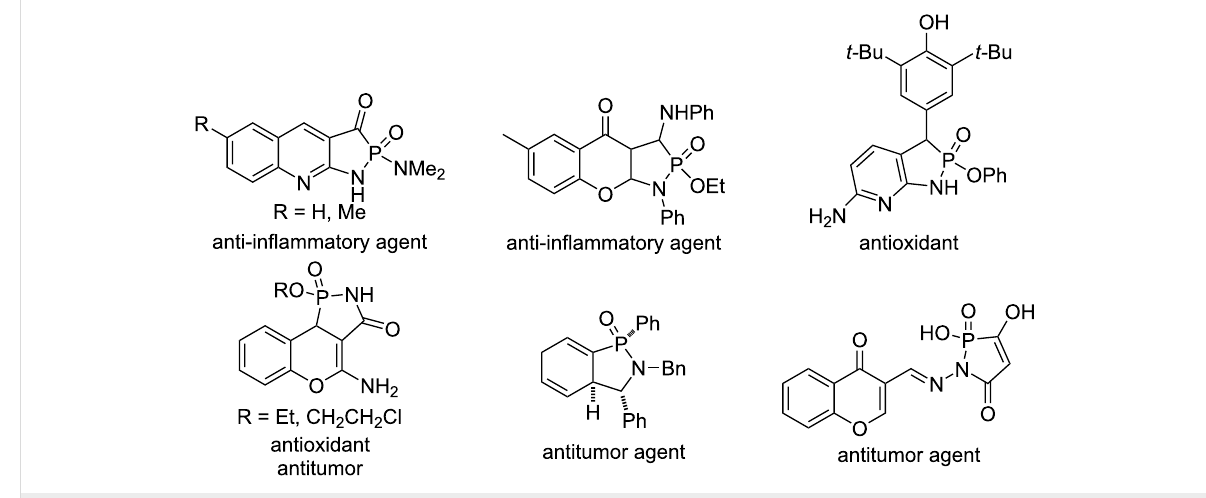
Figure 1: Biologically active 1,2-azaphospholine 2-oxide derivatives.